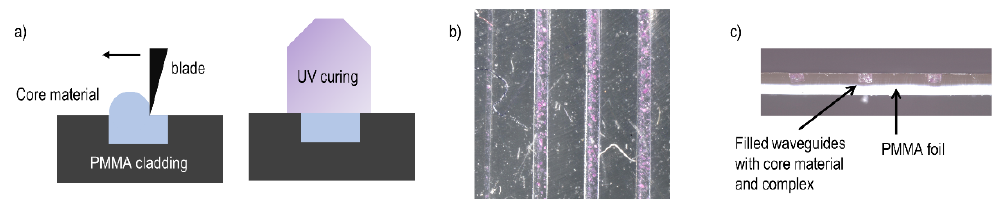
Figure 4. Fabrication scheme and image of created waveguide. ( a ) Waveguide core filling procedure, doctor blading, and UV curing; ( b ) Waveguide with molecular complex in the low-spin state (purple particles) embedded inside the core; ( c ) Side facet view of the fabricated waveguide structure. The images were obtained by confocal microscopy.